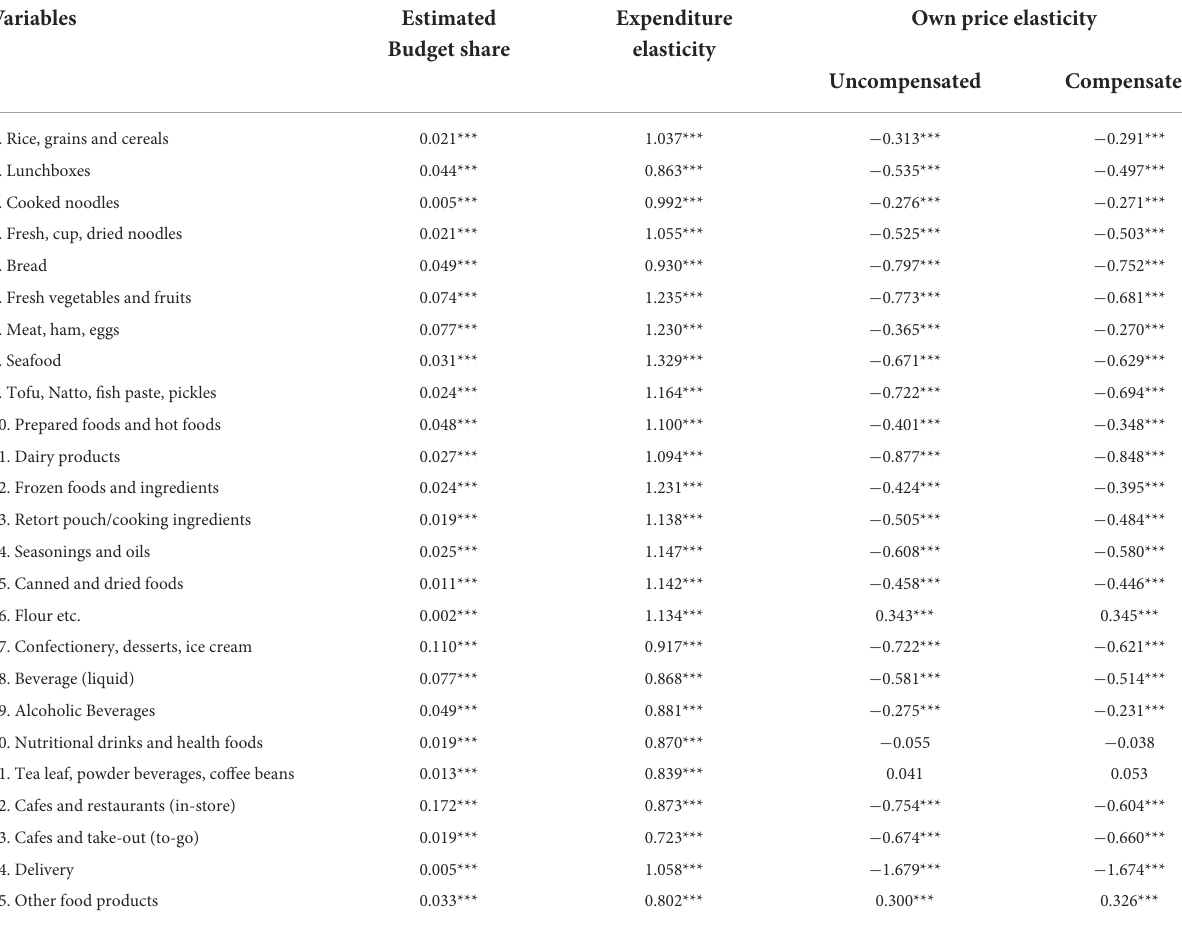
TABLE 4 Estimated budget share, elasticities of Model